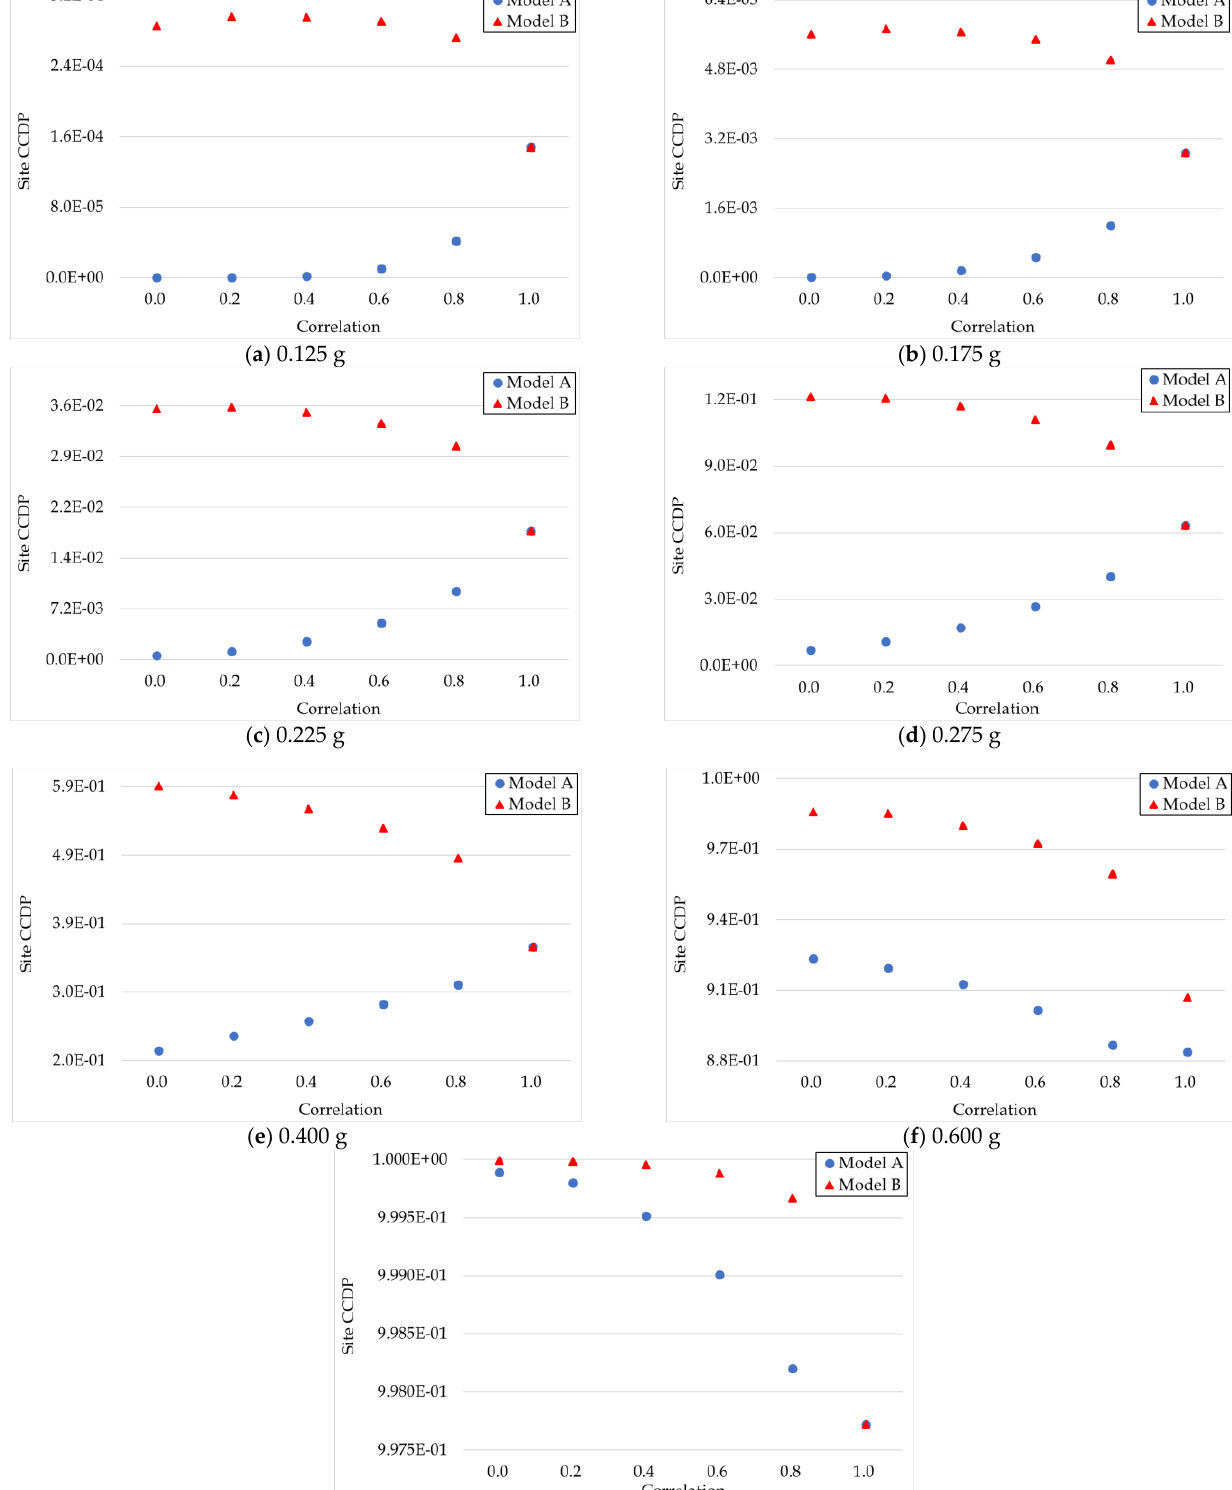
Figure 16. Plots of SCDF versus seismic correlation.